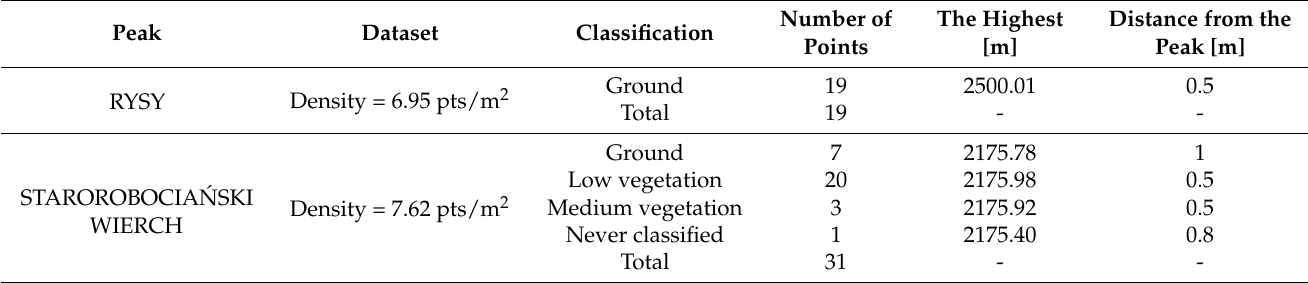
Table 5. Polish point clouds’ density, the analysis of points within a radius of 1 m from the OSM peak. Peak Dataset Classification